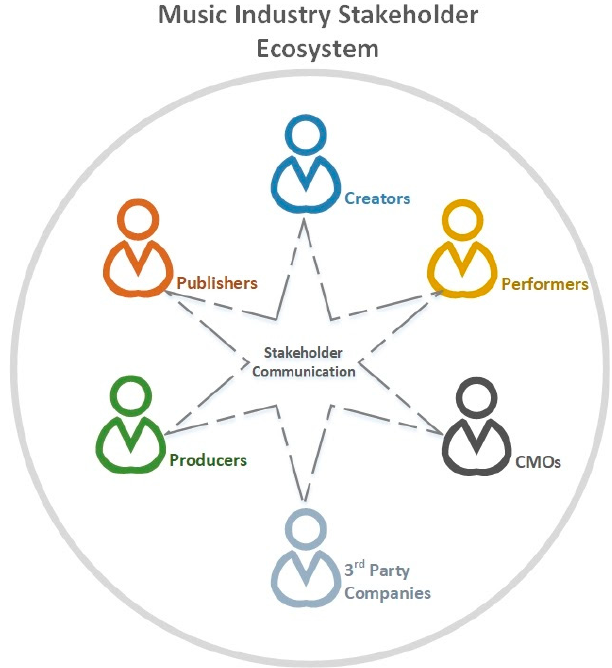
Figure 1. The music industry stakeholder ecosystem.